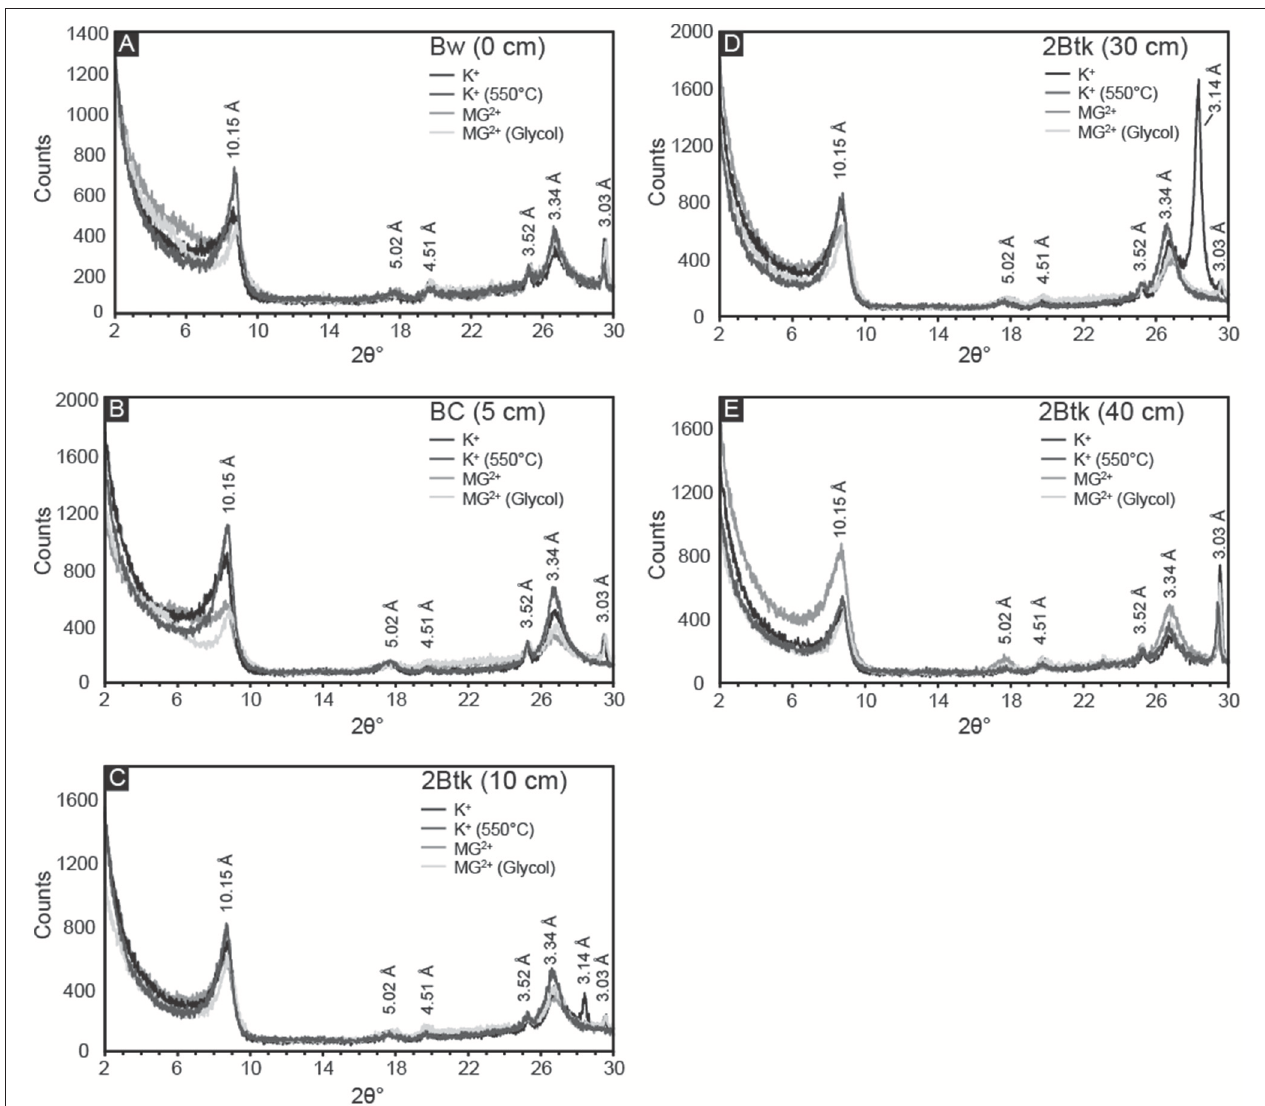
FIGURE 8 | X-ray diffractograms of the < 2 µ m fraction from the first five horizons in NG15-B: (A) Bw, (B) BC, and (C–E) three samples from the 2Btk horizon. Four treatments were applied to all samples: K-saturation, heating to 550 ◦ C of K-saturated samples, Mg-saturation, and ethylene glycolation of Mg-saturated samples. Illite is identified by the presence of peaks at 10.15, 5.02, and 3.34 Å. Peaks associated with smectite (17.5 Å) and kaolinite (7.18 and 5.38 Å) were not observed, and the lack of change with glycolation or heat treatments further supports an interpretation of exclusively illitic clay